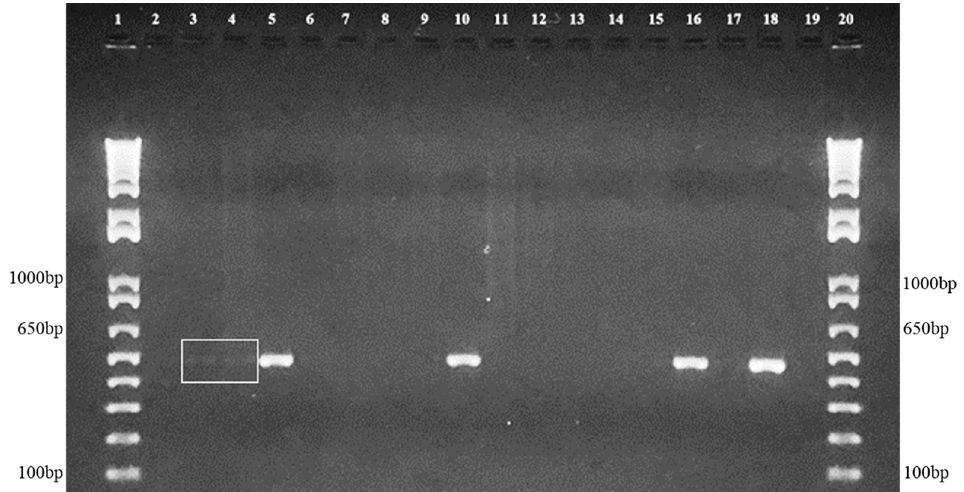
Figure 2. Representative agarose gel of the positive soil samples, demonstrating species-specific amplification of 469 bp fragments compatible with S. brasiliensis . 1 and 20 = Molecular Weight (1 kb Plus–Invitrogen), 2 to 10 samples from Seropédica and 11 to 17 samples from Nova Iguaçu, 18 = Positive control S. brasiliensis (IPEC 16490) and 19 = Negative control. The white square highlights two positive samples with low-intensity bands.